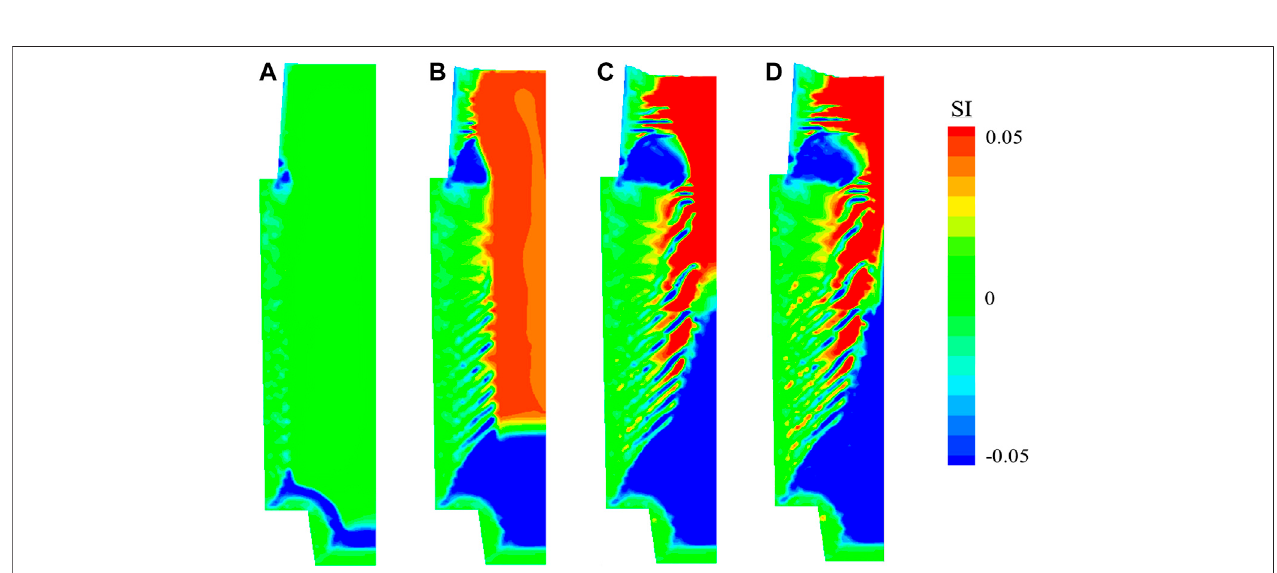
FIGURE 3 | Predicted segregation index (SI) in the left half of the 36-ton ingot at different times: (A) 0.5 h, (B) 2 h, (C) 5 h, (D) end of solidi fi cation.